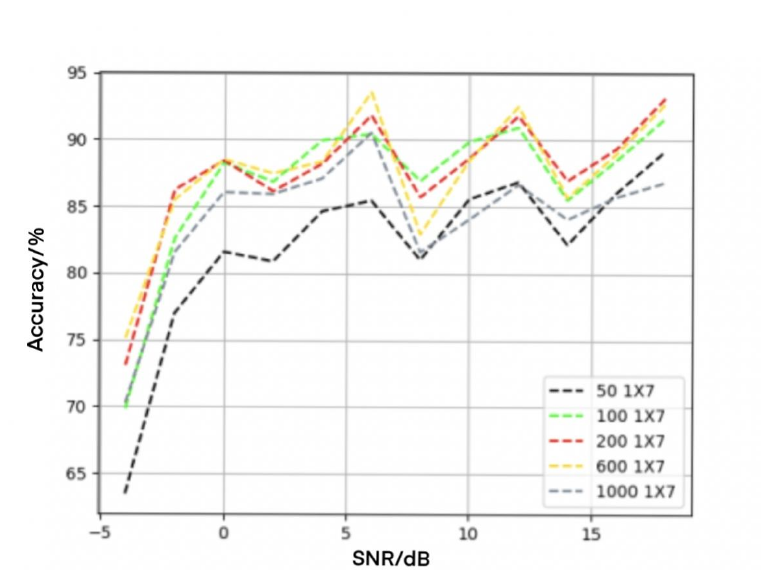
Figure 5. Effect of different convolution kernels on recognition rate (size 1 × 7).